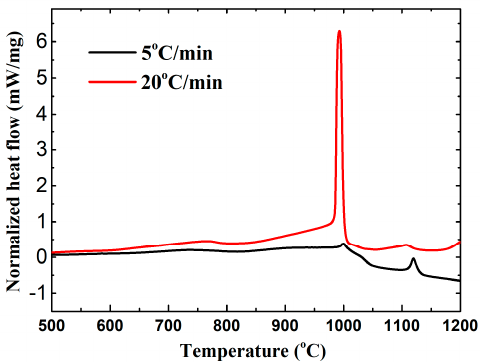
Figure 1. The differential thermal analysis (DTA) curves of 20 wt % Ni-Ti-C green bodies at heating rates of 5 °C/min and 20 °C/min.